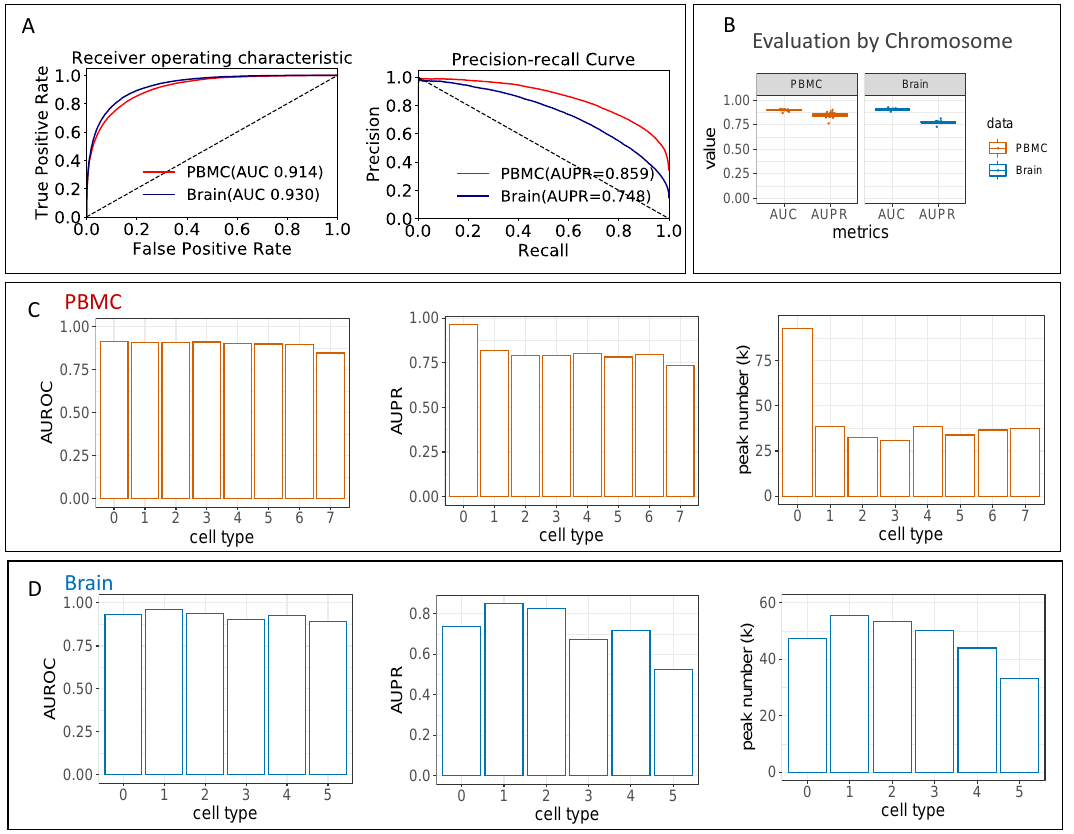
Figure 3. scEpiLock performance on the PBMC scATAC-seq data ( A ) ROC and PR curves for the PBMC and Brainsc ATAC-seq data. ( B ) Model performance on hold-out chromosomes. ( C , D ) AUC and AUPR and peak number counts for each cell type. ( C ) PBMC data, 0 to 7 represent CD14+ monocytes, CD4 memory cells, CD8 effector, CD4 naïve cells, CD8 naïve cells, pre-B cells, double negative T cells, and NK cells. ( D ) Brain data, 0 to 5 represent excitatory neurons, inhibitory neurons, microglia, oligodendrocytes, astrocytes, and OPCs.